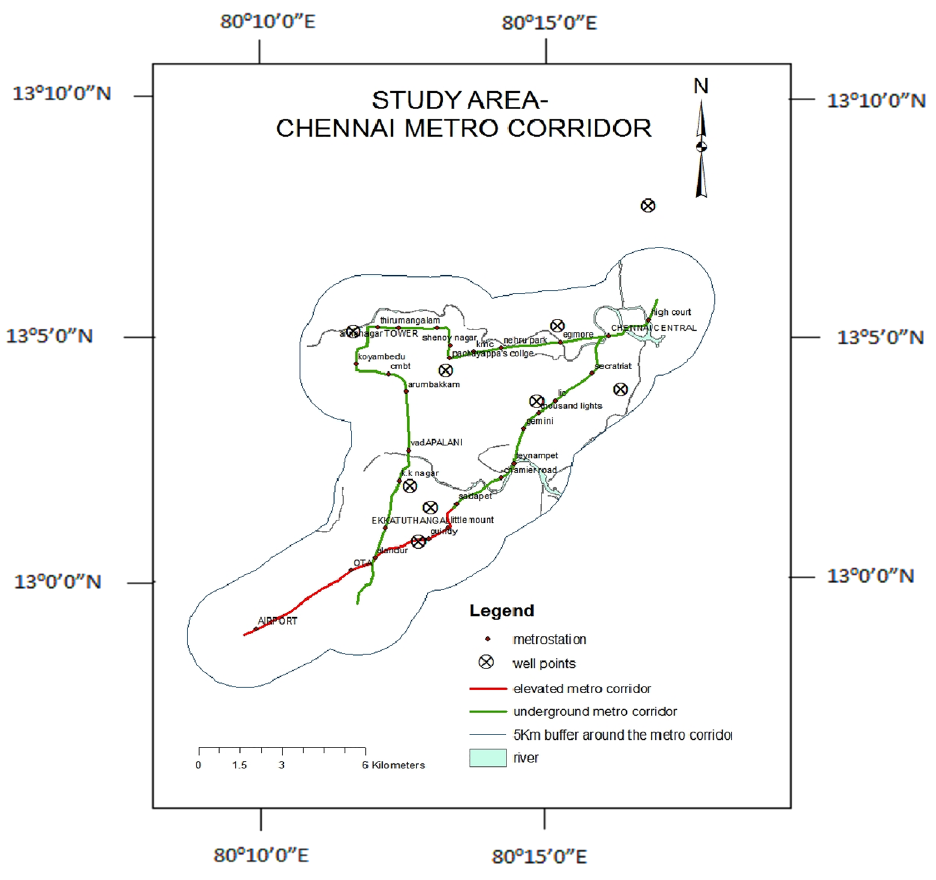
Figure 2. The observation wells in the study area of the underground Metro Rail Corridor, Chennai, Tamilnadu,